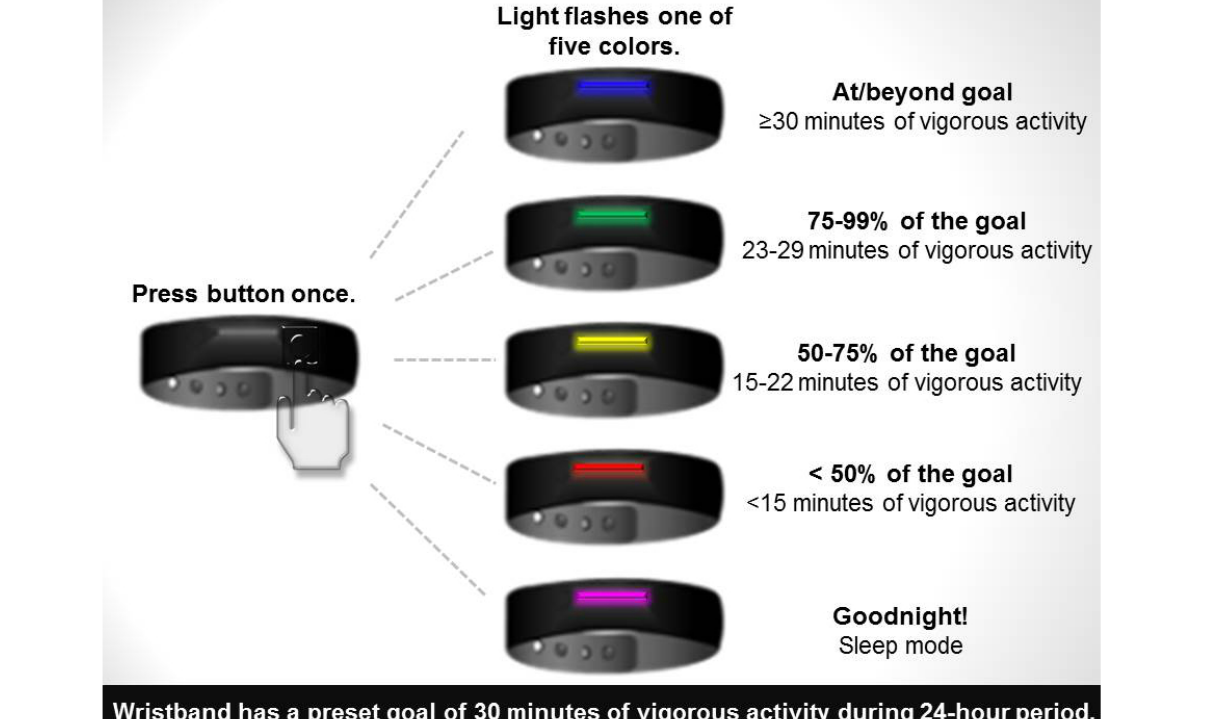
Figure 3. Physical activity-monitoring wristband colored light system; Cardiovascular Health and Needs Assessment Qualitative Study, 2014.